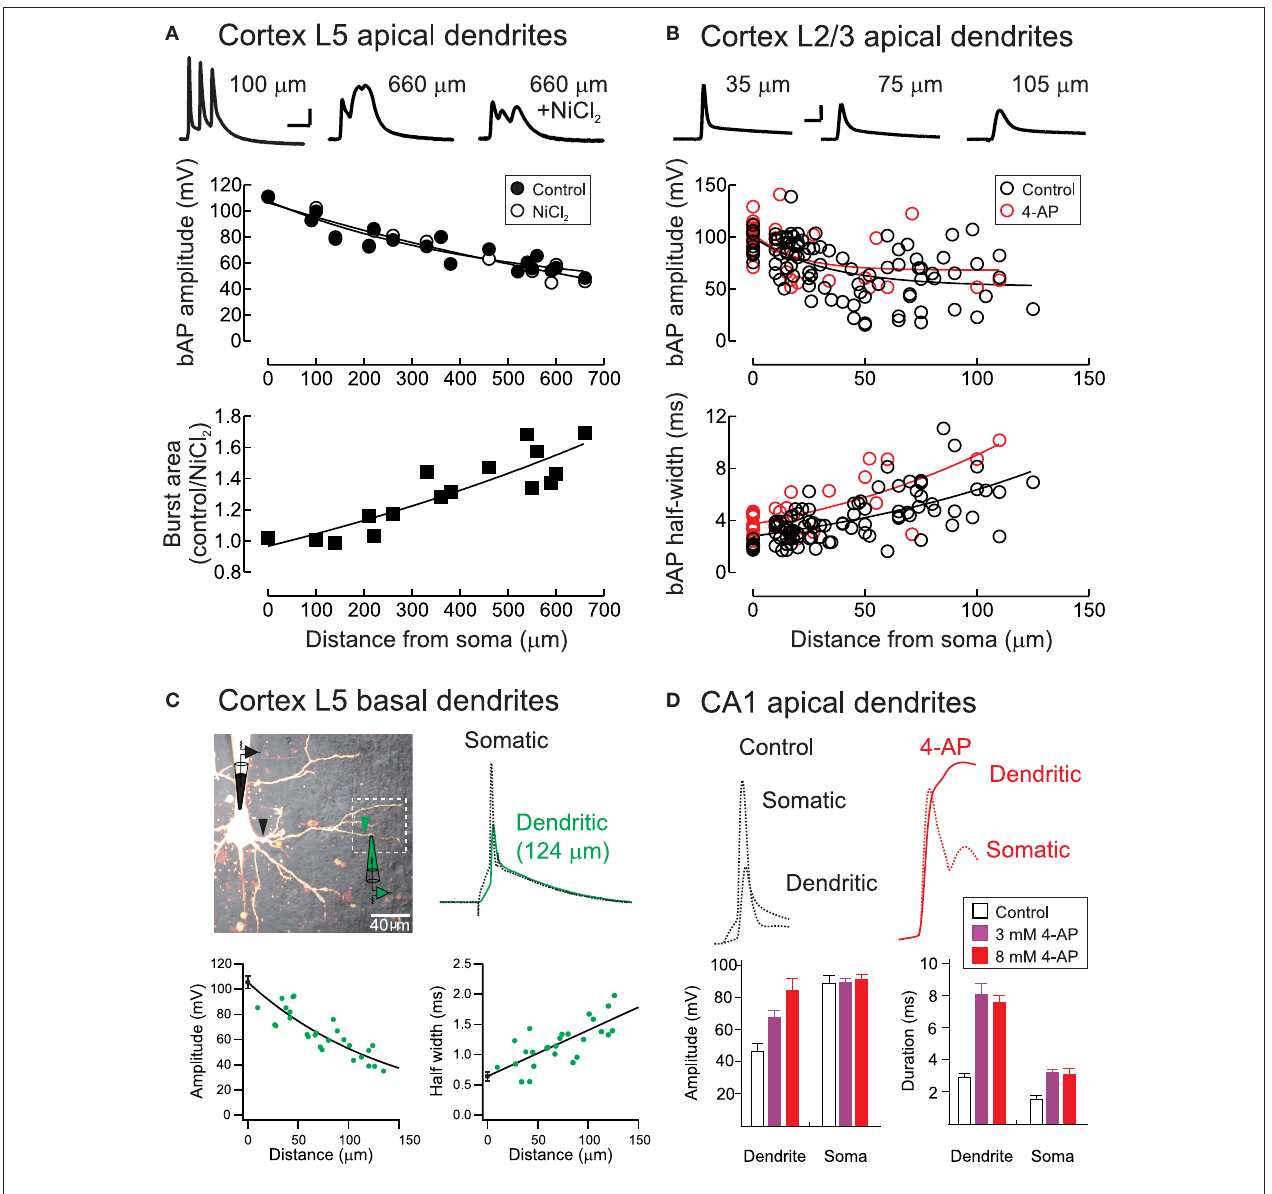
Backpropagation of single action potentials in layer 2/3 pyramidal cells in rat visual cortex. Red symbols indicate experiments performed with the A-type K + channel blocker 4-AP in the recording pipette. Scale bar, 5 ms, 40 mV. From Froemke et al. (2005). (C) Backpropagating action potentials in basal dendrites of layer 5 cortical pyramidal neurons. From Nevian et al. (2007). (D) Backpropagating action potentials in apical dendrites of hippocampal CA1 pyramidal neurons are enhanced in amplitude and duration by bath application of 4-AP. From Hoffman et al.